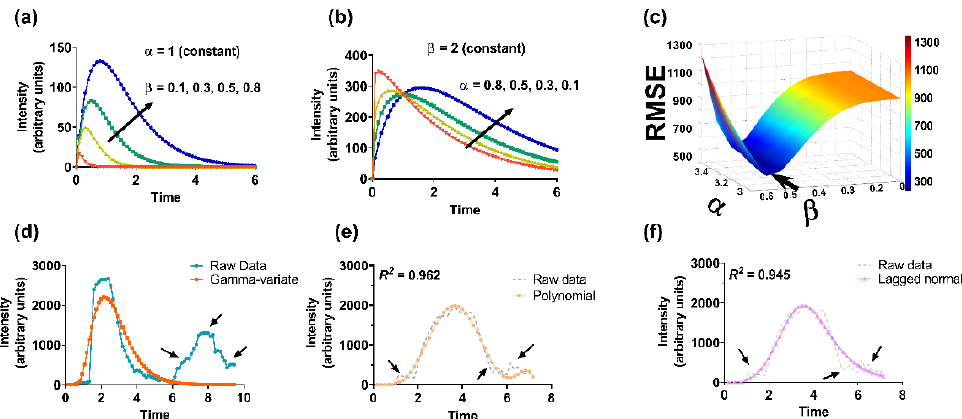
Figure 1. Illustration of curve fitting and optimization process. ( a – d ) GV curve fitting by optimizing unknown parameters, ( a ) α and ( b ) β . Change in β changes the magnitude whereas variation in α changes the shape of the curve (rate of decay), ( c ) selection of α and β based on least root mean square error ( RMSE ) (arrow), ( d ) raw data, and final reference curve based on GV function. Reference curves based on ( e ) polynomial, and ( f ) lagged normal curve-fit functions. Recirculation and random intensity variations (shown by arrows in raw data) are absent in the fitted curves.